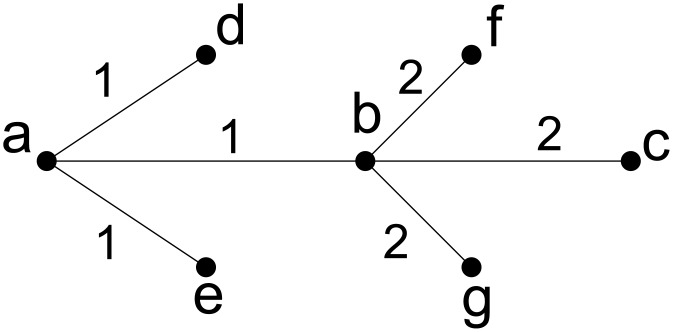
An Auxiliary Graph derived from the graph in Fig 2.